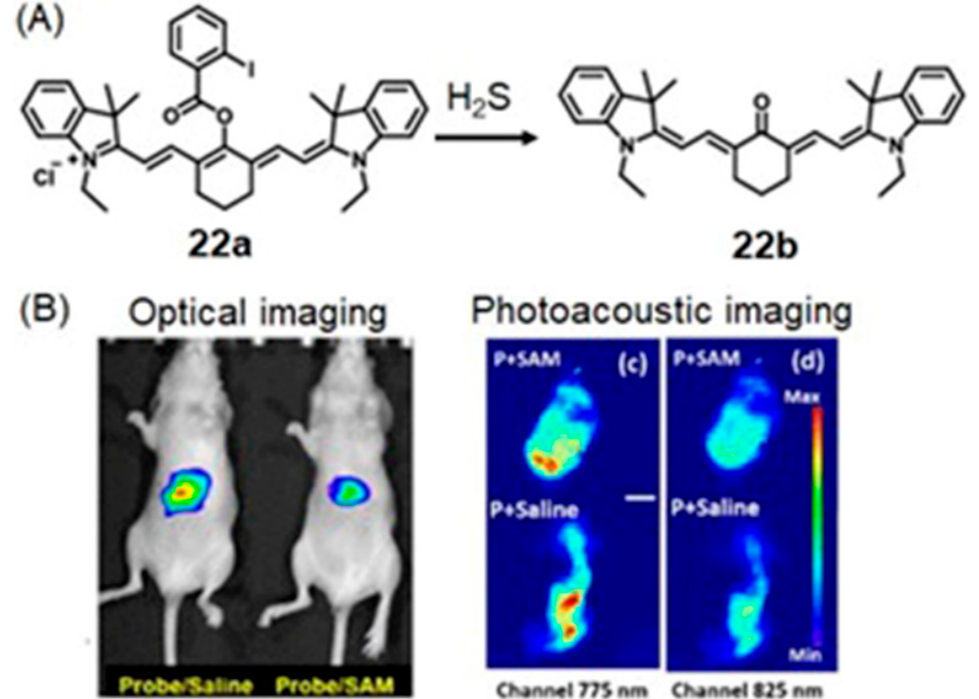
Figure 45. In vivo studies of complex 22 were performed using 6-week-old mice. ( A ) Chemical structures and schematic diagram of H 2 S-sensing mechanism of the probe. ( B ) Fluorescence images of mice injected with 22 and saline S -adenosyl-L-methionine (trigger H 2 S upregulation). Photoacoustic images of livers from mice injected with 22 and S -adenosyl-L-methionine and saline. (p indicates probe 22 ). Images were recorded using channels 775 and 825 nm. Scale bar = 6 mm. Adapted with permission from Chen, Z.; Mu, X.; Han, Z.; Yang, S.; Zhang, C.; Guo, Z.; Bai, Y.; He, W. An optical/photoacoustic dual-modality probe: ratiometric in/ex vivo imaging for stimulated H 2 S upregulation in mice. J. Am. Chem. Soc. , 2019 , 141 , 17973–17977. Copyright 2019 American Chemical Society [356].